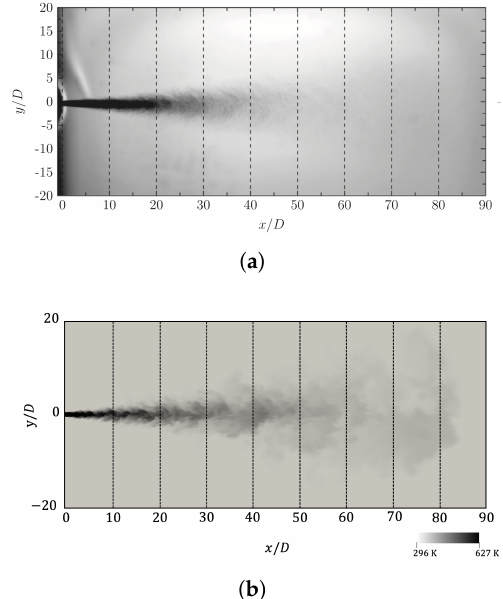
Figure 6. ( a ) Exemplary shadowgram of a hexane jet ( T e = 600K, p ch = 5MPa, T ch = 293K) reprinted from Baab et al. [10] (a shadowgram corresponding to one of the considered cases was not provided in Ref. [10]); ( b ) instantaneous temperature field on the midplane of case SoS _1 (hexane) ( T e = 627K, p ch = 4.99MPa, T ch =